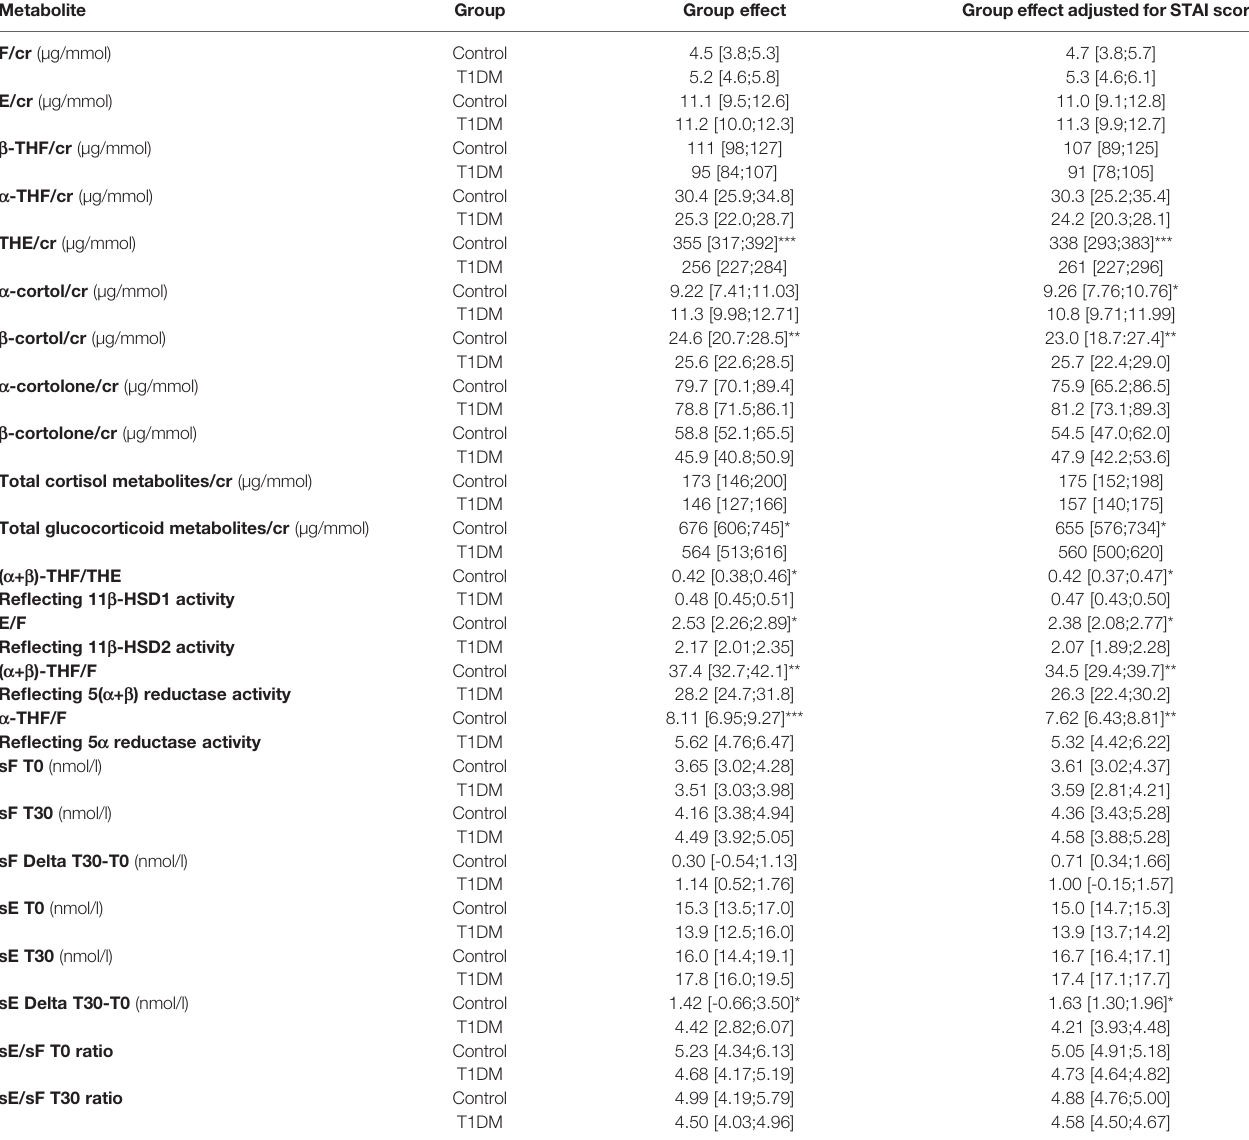
TABLE 2 | Metabolites of cortisol and cortisone of the T1DM and control